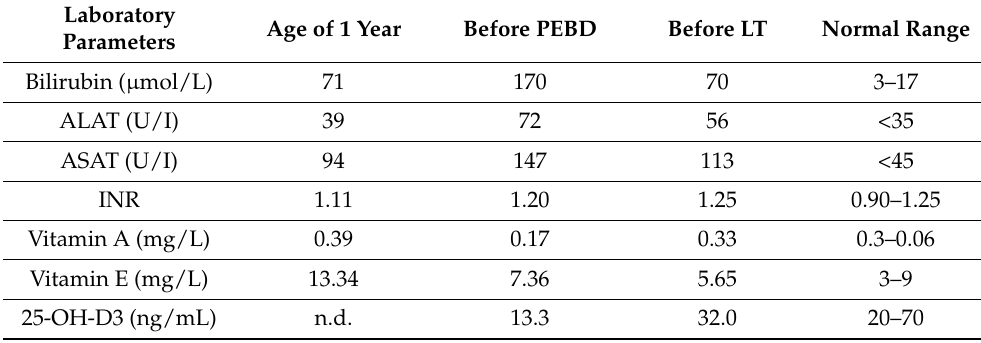
Table A1. Liver enzymes, fat-soluble vitamins (under substitution) at the age of 1 year, before PEBD and before LT. PEBD, partial external biliary diversion; LT, liver transplantation; ALAT, alanine aminotransferase; ASAT, aspartate aminotransferase; INR, international normalized